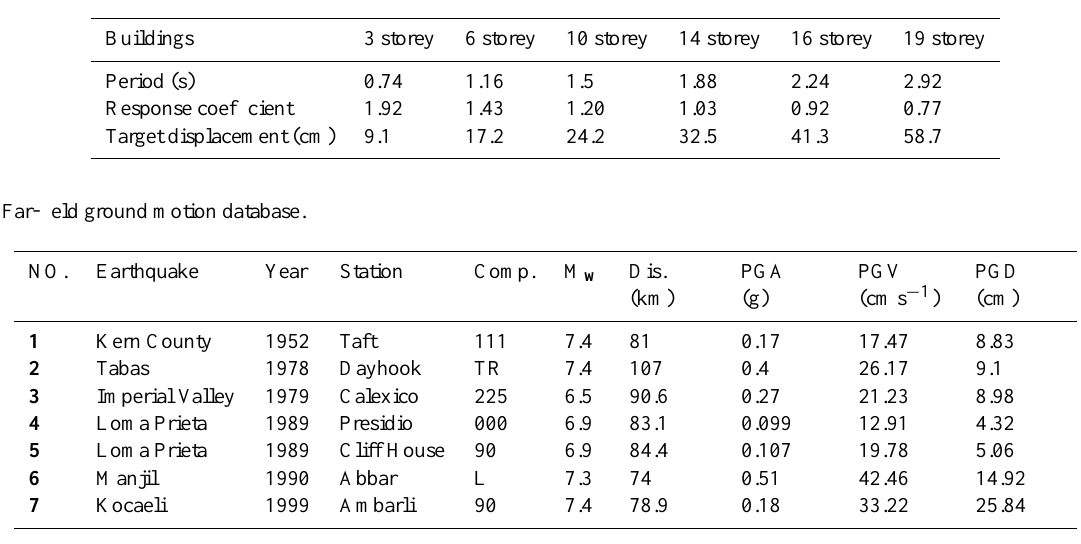
Table 3. Target displacement and periods of buildings.